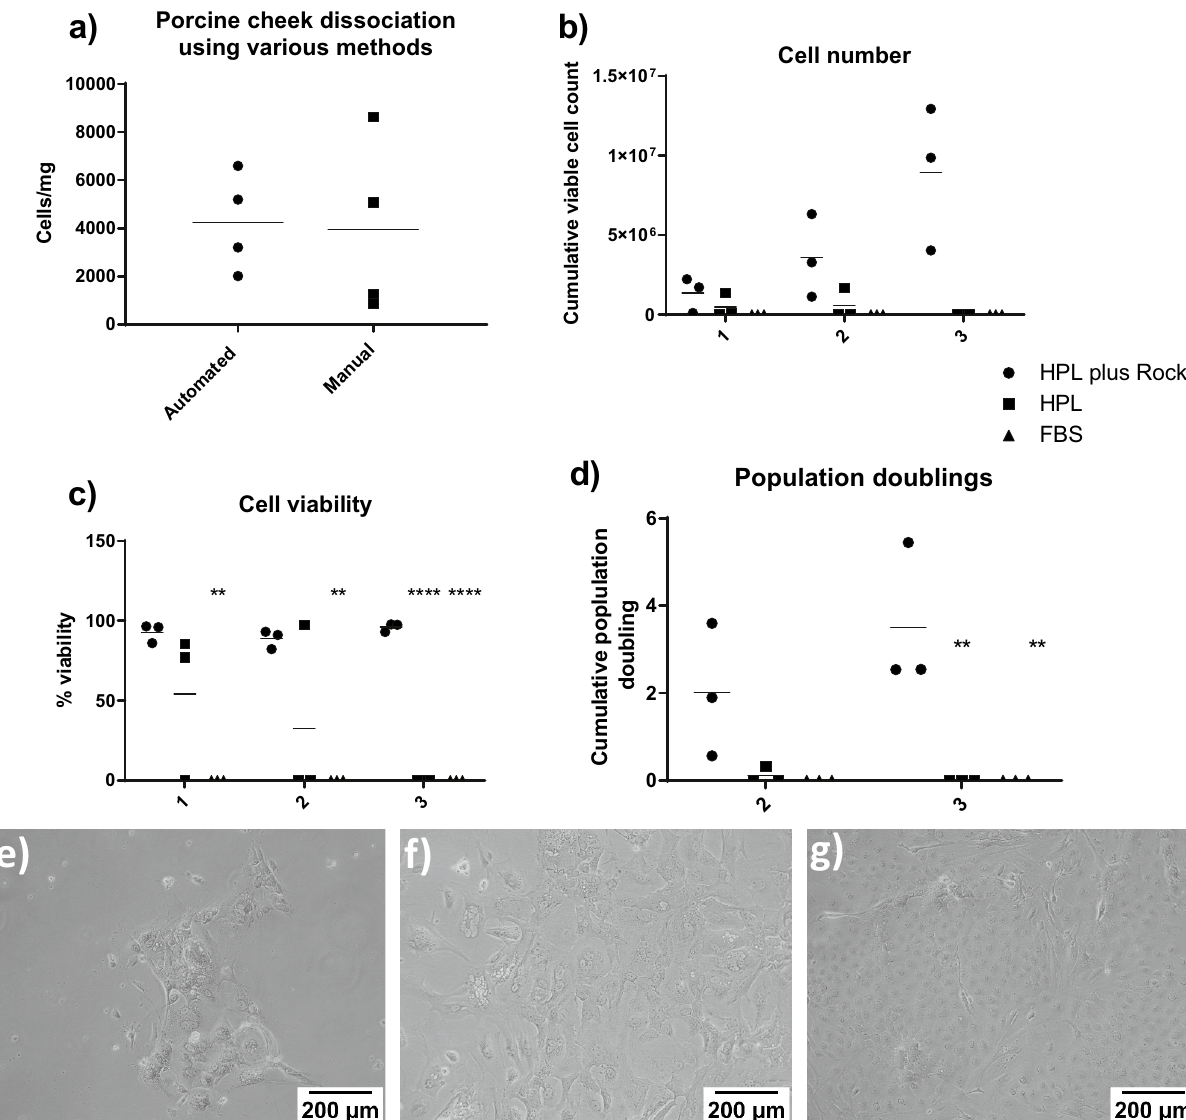
Figure 2. Epithelial cells digestion. The Porcine epithelial cell sheets were digested ( a ) either manually or automatically and the cell number counted ( a ). Data shows mean ± SD, n = 4. Comparison of epithelial cells automatically digested, grown on primary feeder layers in FBS, HPL or HPL Y-27632 medium. Cell number ( b ) viability (c ) and population doublings ( d ) were recorded up to passage 3. Data shows mean ± SD; n = 3. *P ≤ 0.05, **P ≤ 0.01, ****P ≤ 0.0001 except d , which shows median + interquartile range. Cells grown in media containing FBS ( e ), HPL ( f ) and HPL plus Y-27632 ( g ). n = 4, scale bar shows 200